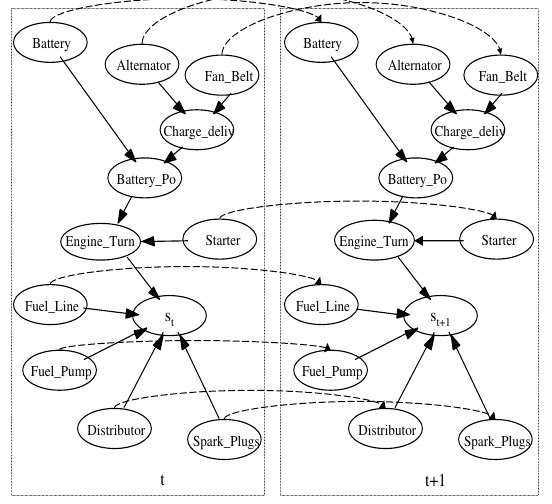
Fig. 3. DBN representation of DAP.